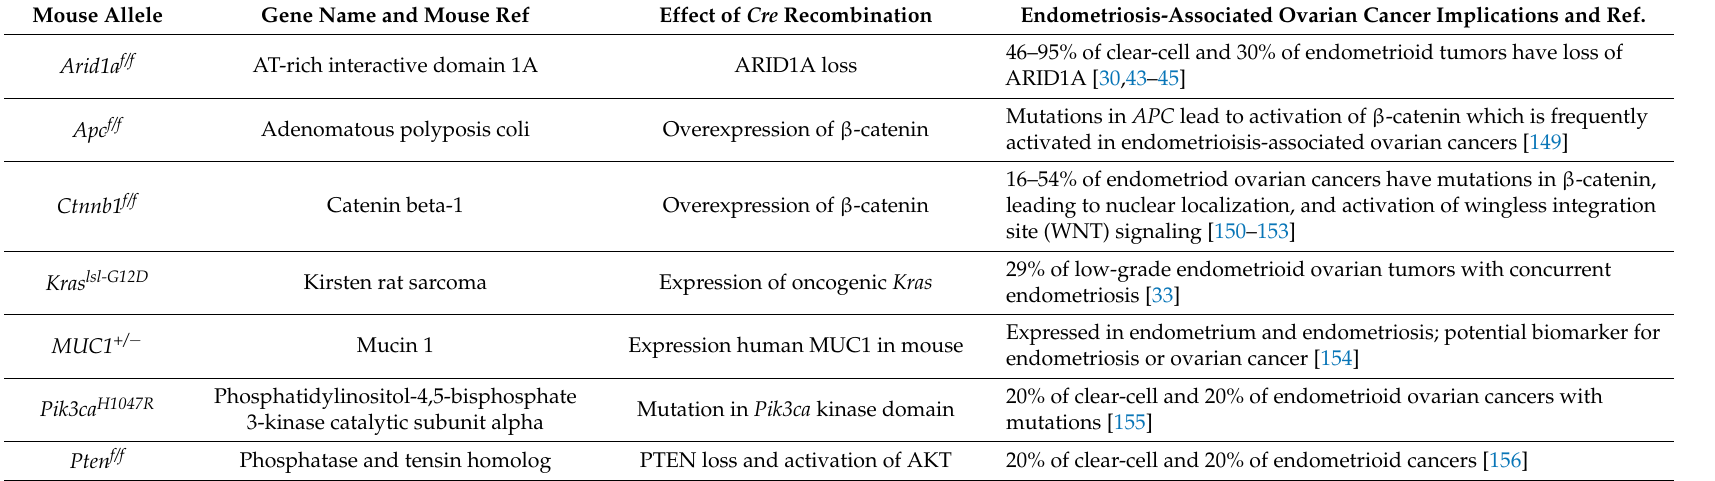
Table 2. Genes important in mouse models of endometriosis-associated ovarian cancer.